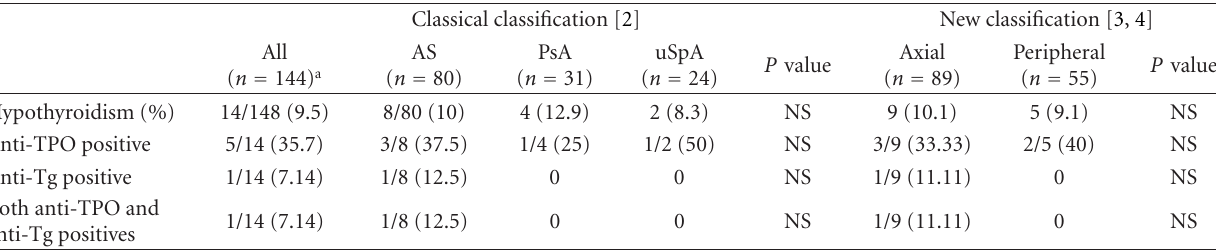
Table 3: Hypothyroidism in SpAs.